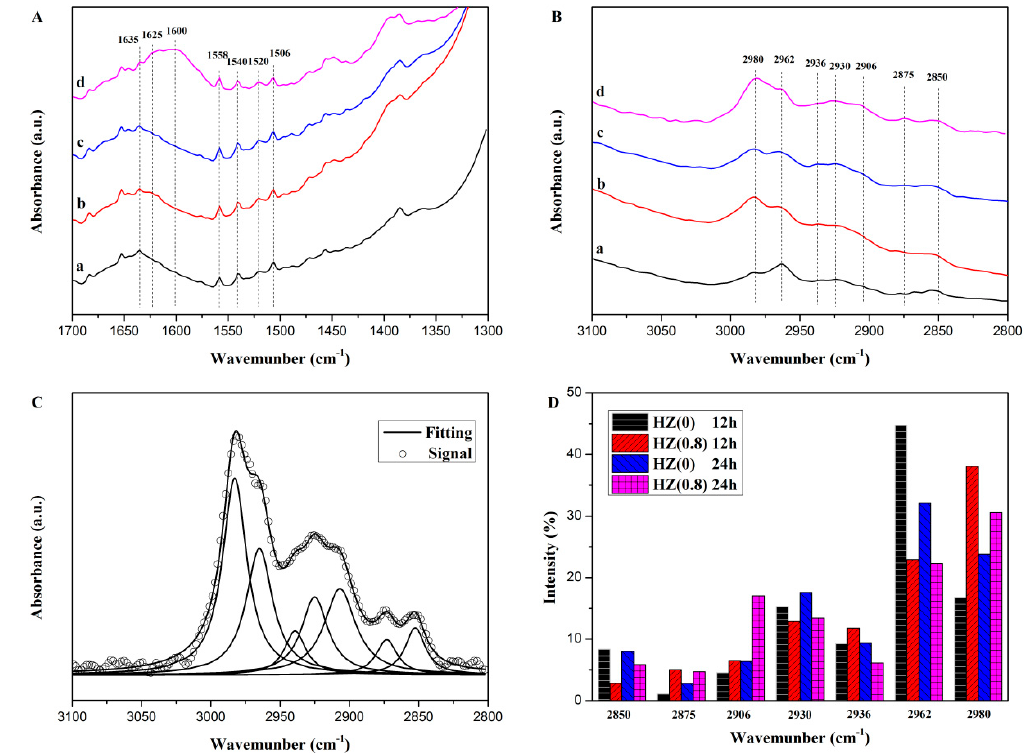
Figure 10. FTIR spectra of the used HZ(0) and HZ(0.8) catalysts after propane aromatization for 12 and 24 h at 550 °C with WHSV of propane being 0.6 h − 1 and N 2 /C 3 H 8 ratio being 2.5 in feedstock in the region of ( A ) 1700–1300 cm − 1 and ( B ) 3100–2800 cm − 1 for (a) HZ(0)-12, (b) HZ(0.8)-12, (c) HZ(0)-24, (d) HZ(0.8)-24; ( C ) Deconvoluted CH-region (3100–2800 cm − 1 ) spectrum of HZ(0.8)-24; ( D ) Fraction of intensity (calculated using the area of the peaks in ( B ) of several characteristic vibrational bands of the catalysts in the FTIR region 2800–3100 cm − 1 .